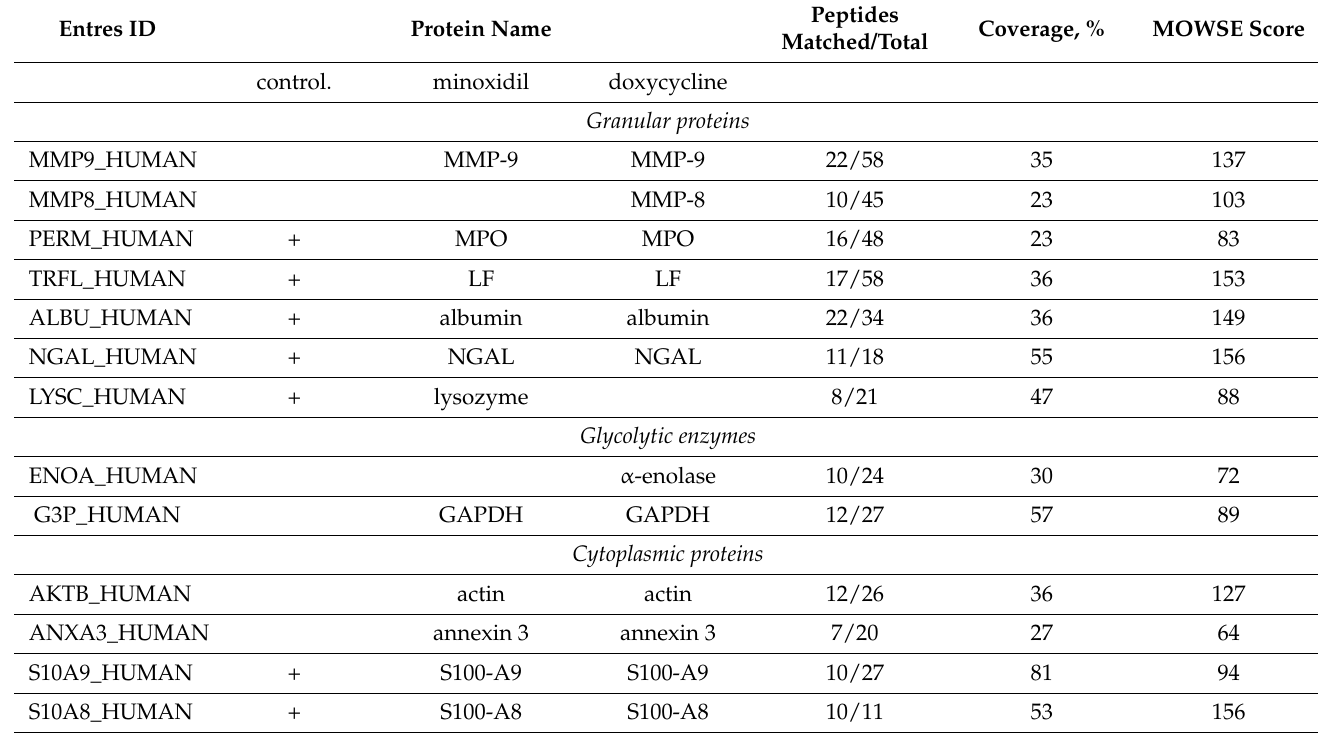
Table 2. List of proteins secreted by neutrophils in adherence to fibronectin in the presence of minoxidil and doxycycline. Neutrophils were incubated over fibronectin-coated substrata for 20 min under control conditions (marked +), or in the presence of 200 µ M minoxidil or 20 µ M doxycycline. Proteins were separated by SDS-PAGE and identified by mass spectrometric analysis. Mass spectrometric analysis data were taken from experiments with doxycycline. Data for lysozyme were taken from experiments with minoxidil. Analogous proteins that were identified in control experiments are marked (+). The list includes proteins that have been reliably identified in three similar